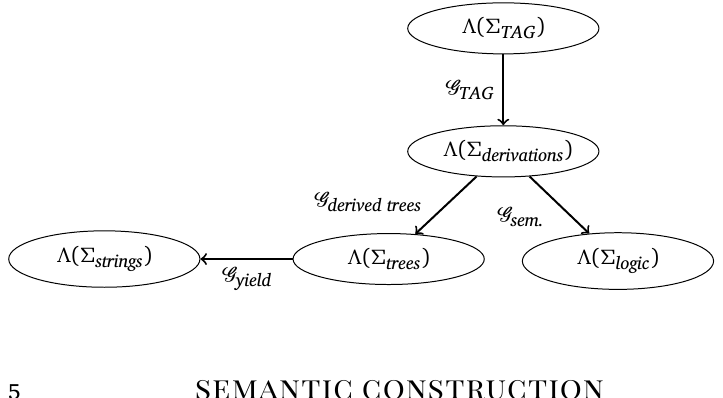
Figure 15: for control